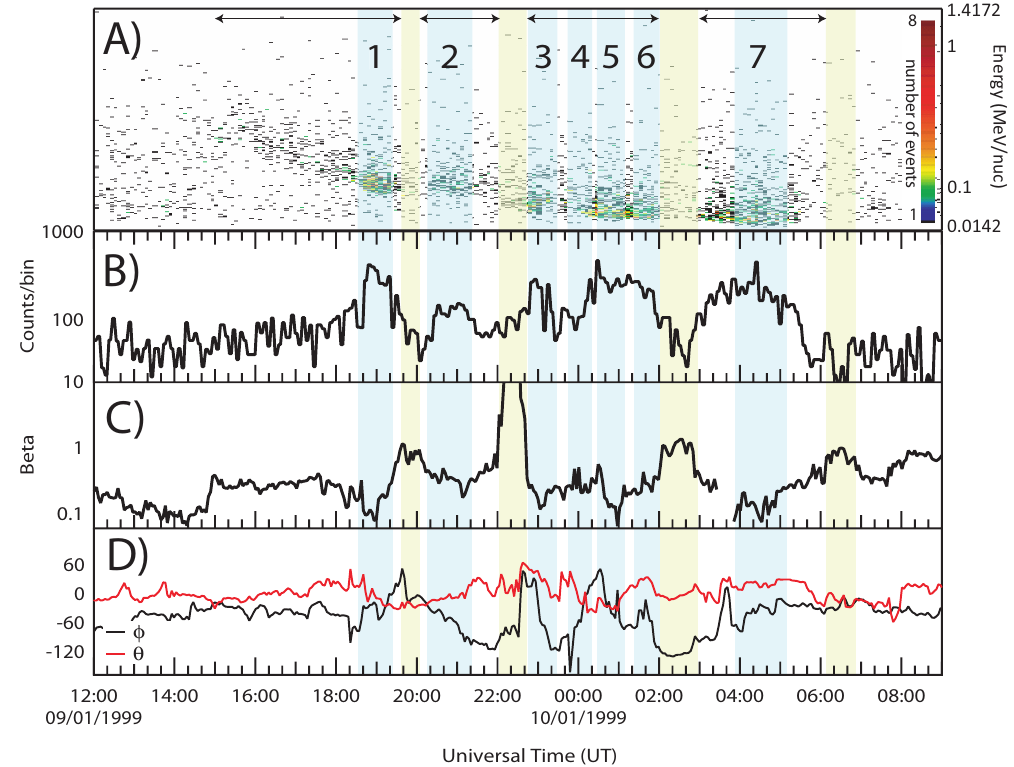
Fig. 1. Combined energetic ions and plasma-magnetic field parameters for the 9–10 January 1999 SEP event (adapted from Trenchi et al., 2013). In panel (a) the energy of ions (in units of MeVnucleon − 1 ) versus their arrival time; in panel (b) the ion counts, integrated over all energies, vs. time, in about 5min bins. In panel (c) the ratio between plasma and magnetic pressures β , and in panel (d) the azimuthal and polar angles of the magnetic field vector, in GSE coordinate system, in the range [− 180 ◦ , + 180 ◦ ] and [− 90 ◦ , + 90 ◦ ] , respectively. The blue-shaded areas highlight the structures reconstructed with the GS